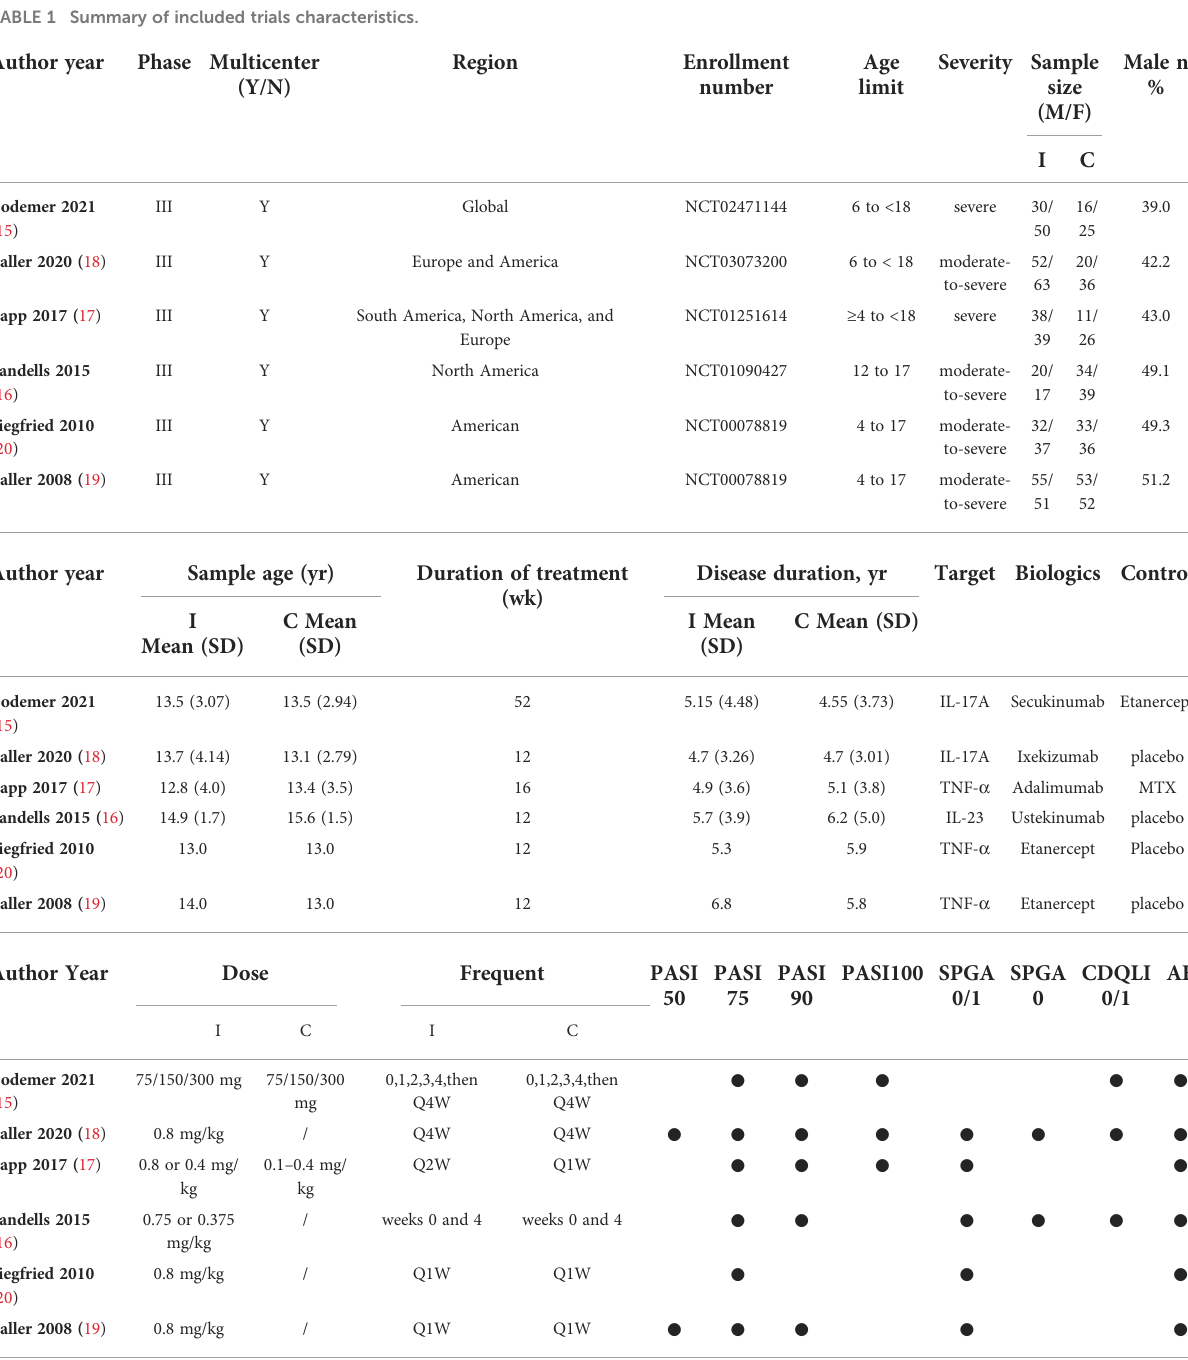
TABLE 1 Summary of included trials